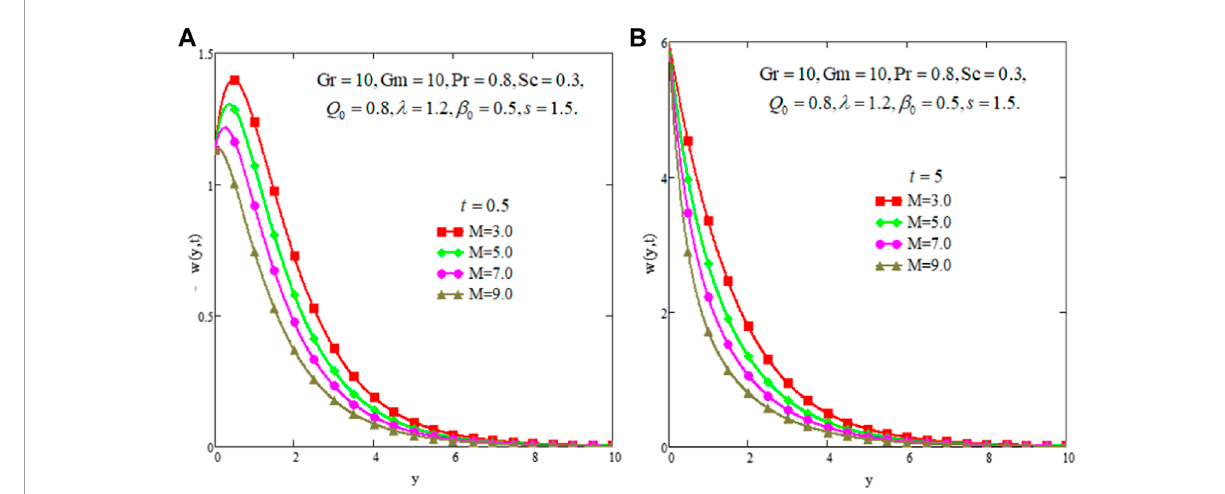
FIGURE 8 Velocity due to M for small time (A) and for large time (B) .